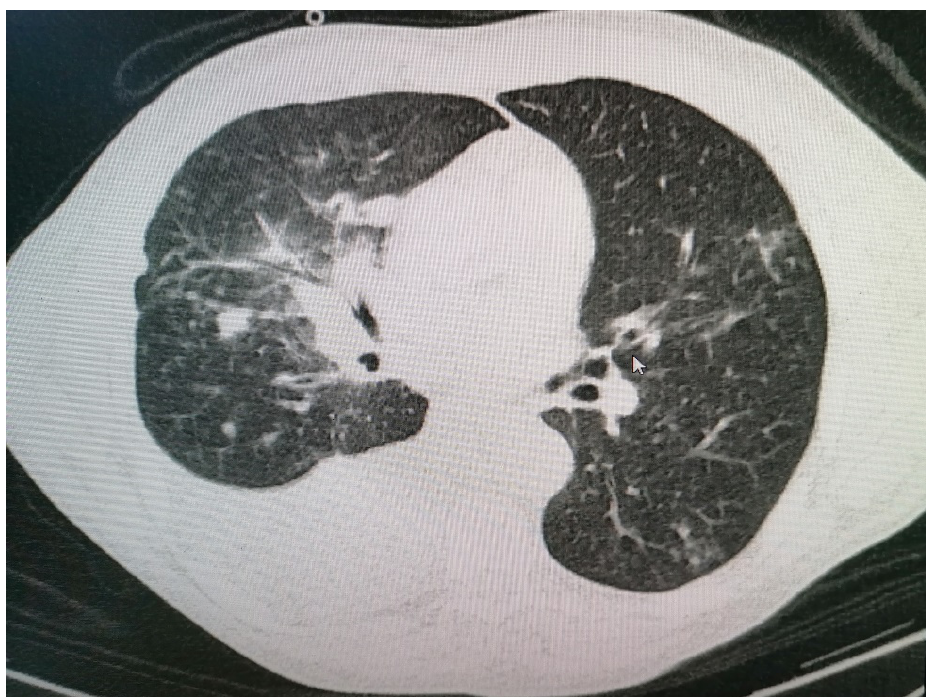
Figure 3. Computer tomography of the patient.